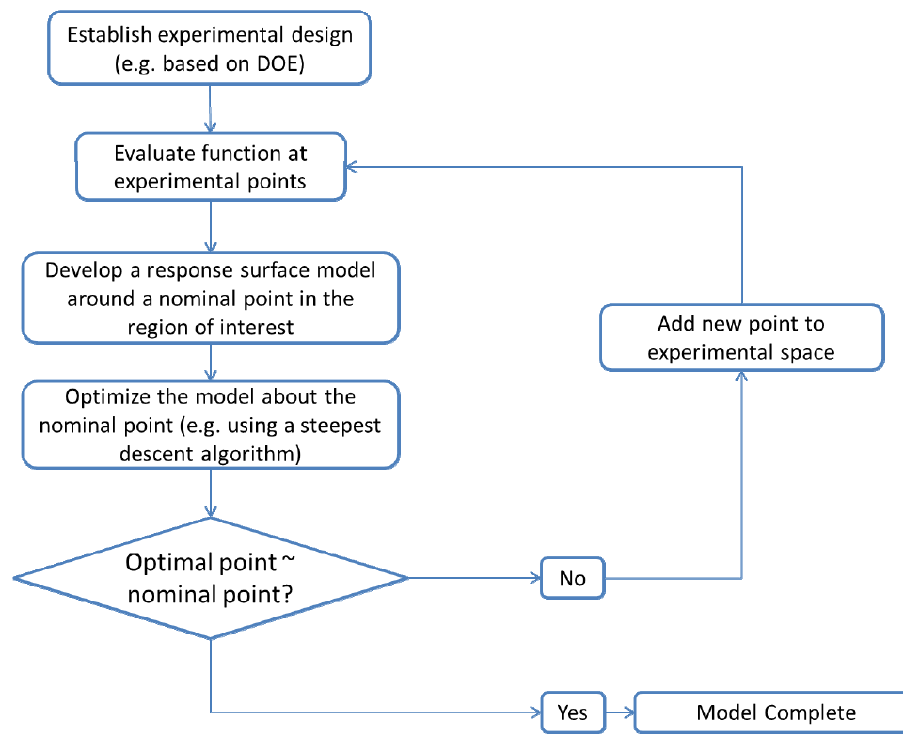
Figure 3. Algorithm for response surface modeling with optimal model development around a region of